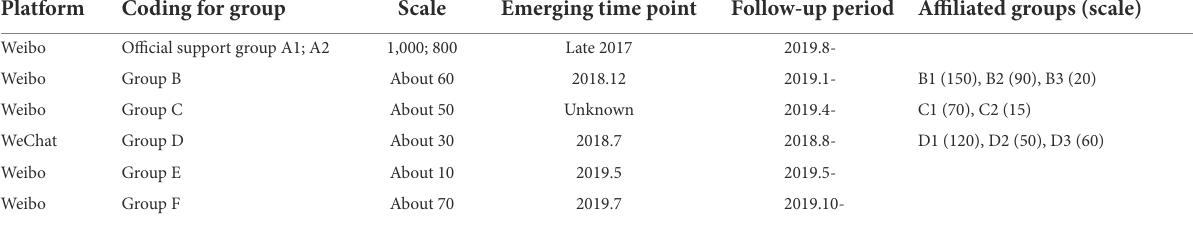
TABLE 1 Information of the main online groups